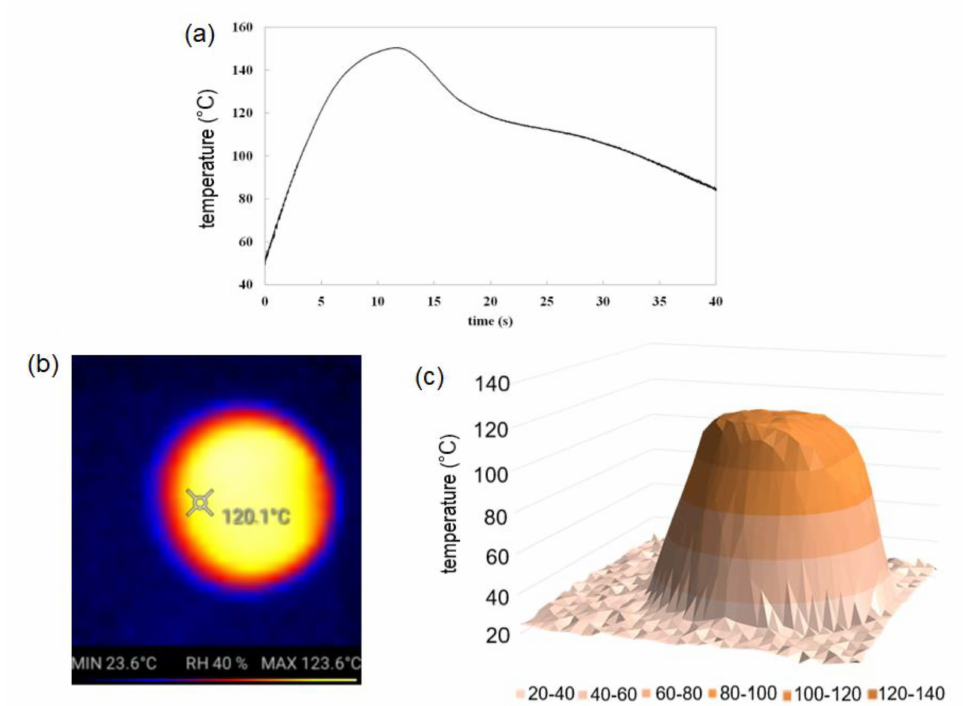
Figure 1. ( a ) Temperature profile of the apatite-coated UHMWPE disk during laser irradiation; ( b ) thermograph taken immediately after laser irradiation; and ( c ) graphical representation of the temperature distribution shown in ( b ).